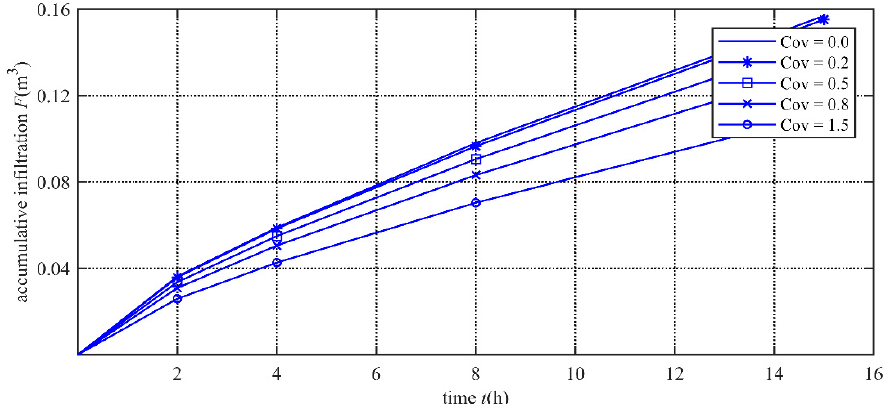
Figure 15. The variation of accumulative infiltration over time.